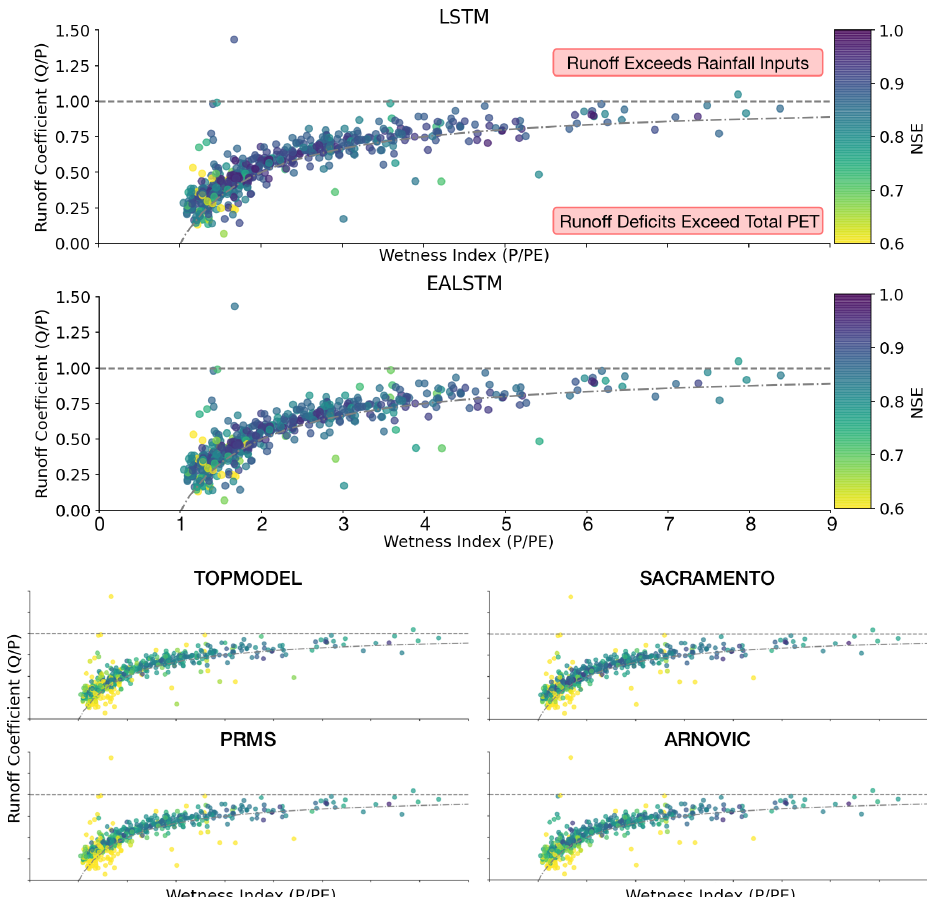
Figure 5. Scatter plot for the relationship between the wetness index, runoff coefficient and the model NSE score. Each point is a catchment, coloured by the NSE score ranging from 0.8 (lighter) to 1.0 (darker). Points above the horizontal line reflect catchments where the observed discharge is greater than the precipitation input to the catchment. Points below the curved line are where runoff deficits exceed total PET in a catchment; therefore, there is excess water in the data, since PET cannot explain the leftover water after accounting for